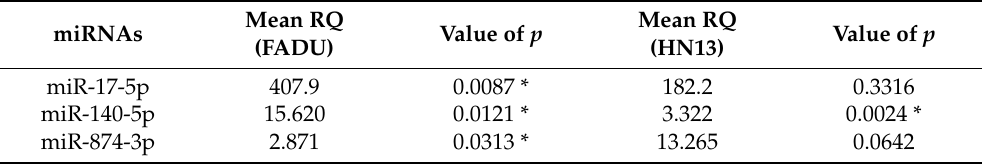
Table 1. Mean relative quantification (RQ) of microRNAs miR-17-5p, miR-140-5p, and miR-874-3p after transfection in HNC cell